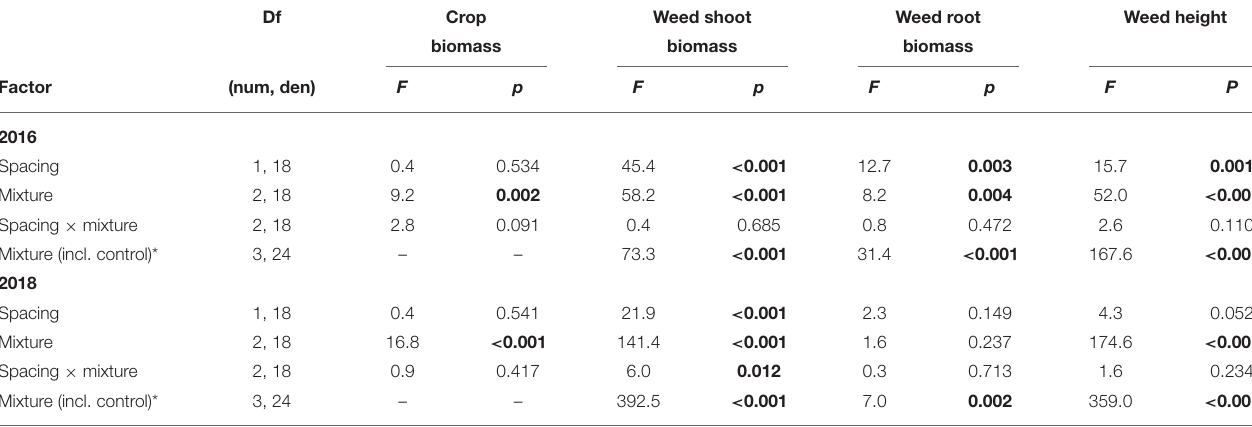
TABLE 6 | Greenhouse experiments (2016 and 2018) mixed model results of crop biomass, weed shoot biomass, weed root biomass, and weed height with crop mixture and row spacing as fixed factors. Df Crop Weed shoot Weed root Weed height